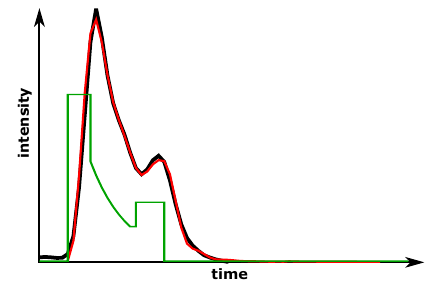
Figure 3. Schematic representation of SVB algorithm; green: dBCS model; red: model of the received signal; black: received signal.